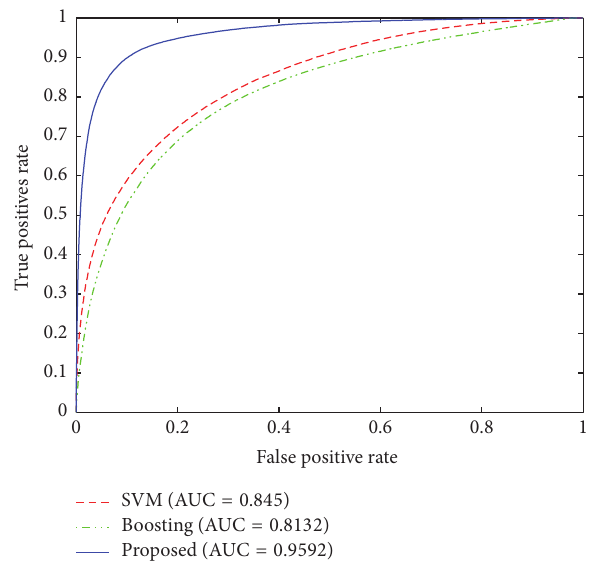
Figure 10: ROC curves